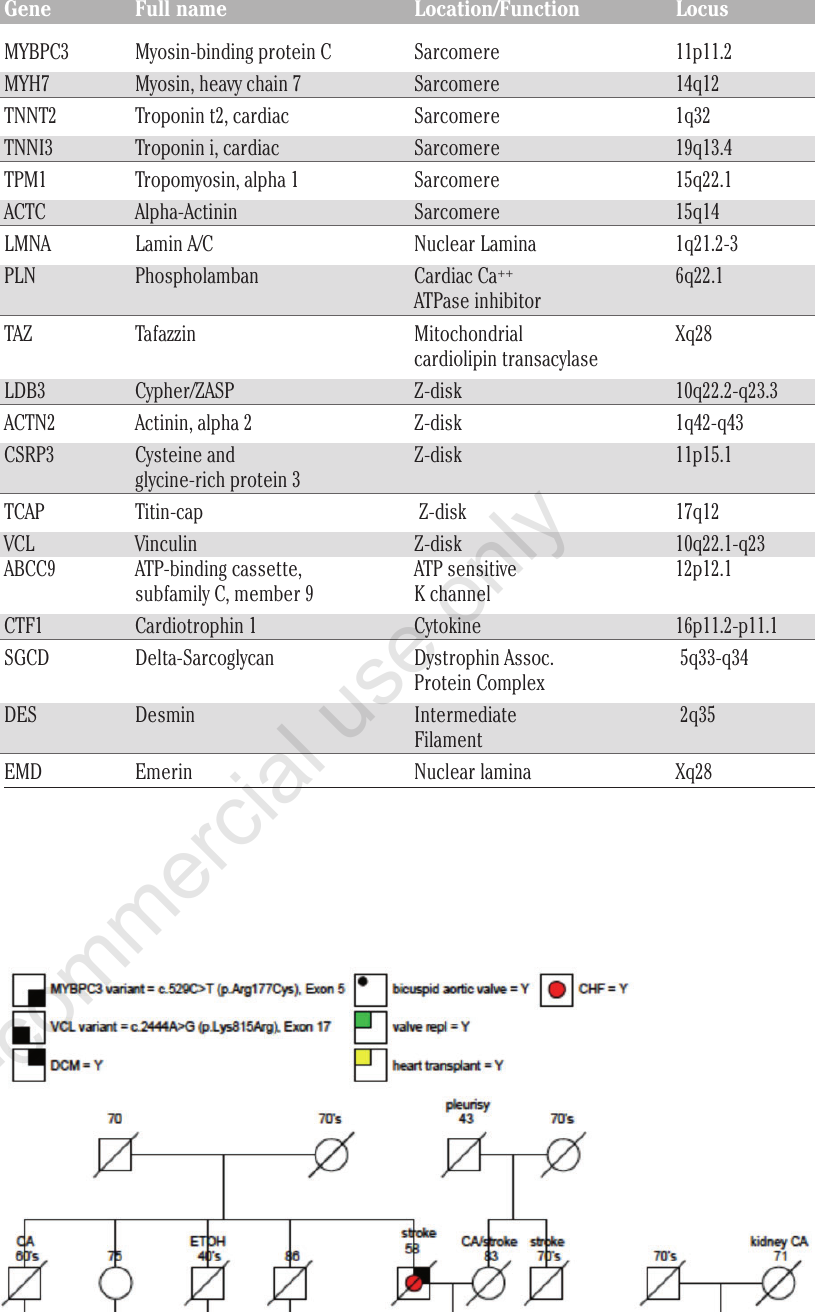
Table 1. Genes tested by dilated cardiomyopathy array based resequencing platform.